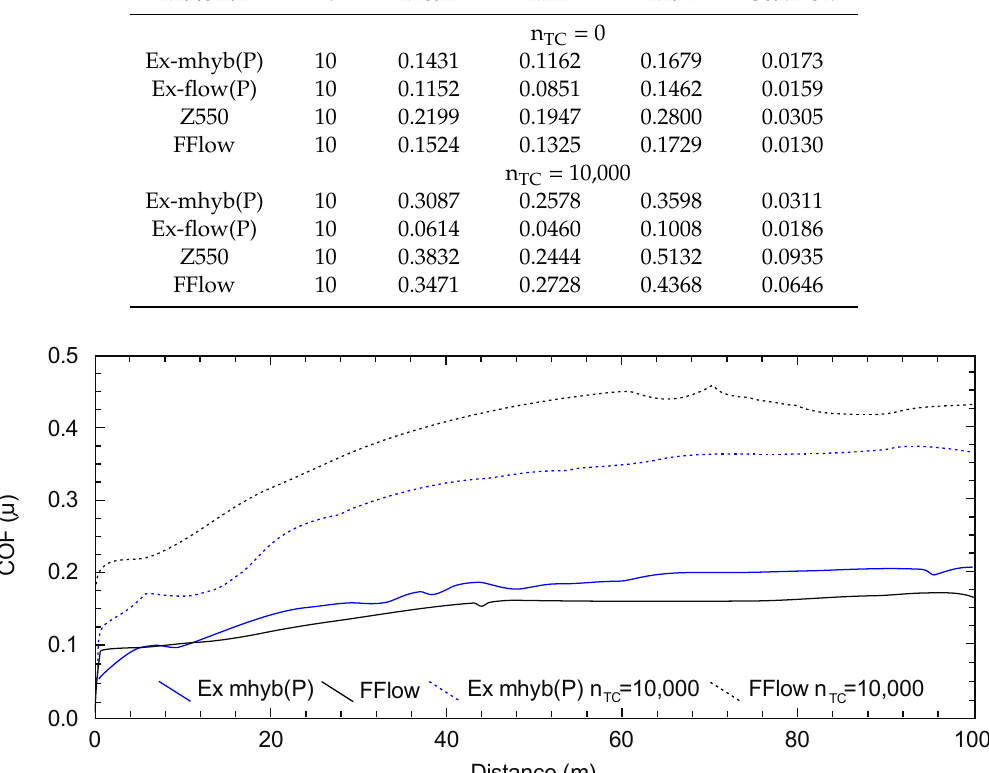
Figure 6. Characteristics of the coefficient of friction ( μ ) depending on the friction path (dashed line refers to hydro-thermally tired samples).